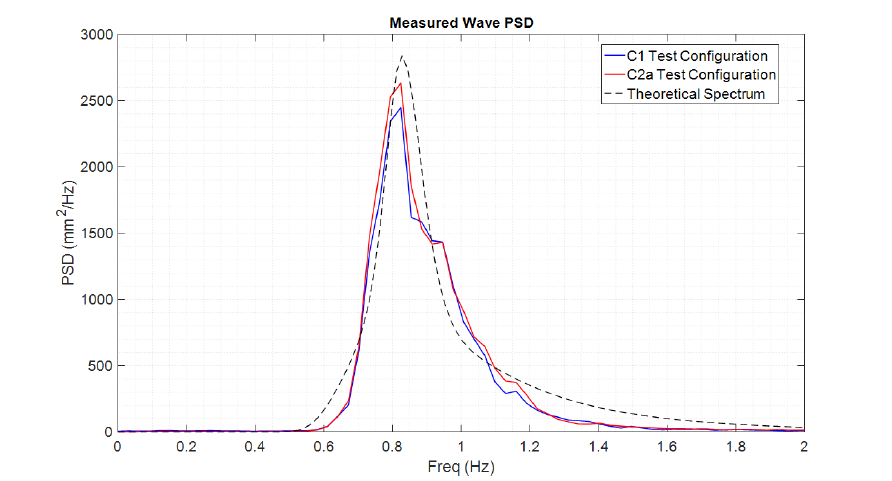
Figure 15. Measured irregular JONSWAP wave spectra compared with the theoretical